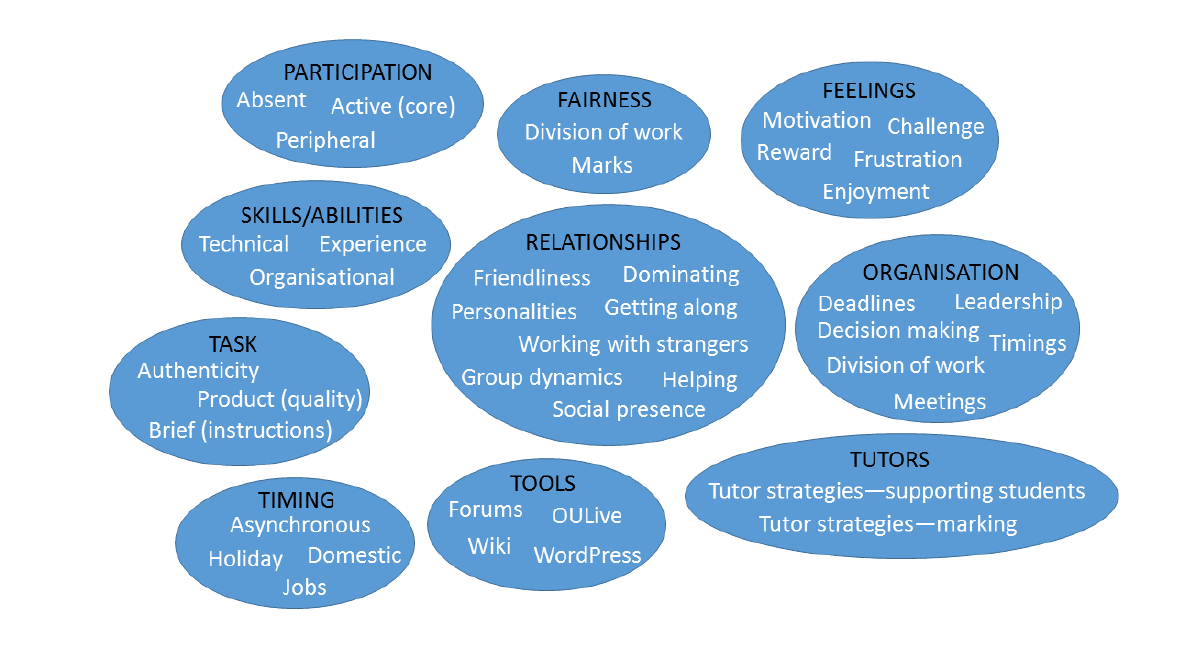
Figure 1 . Codes and subcodes used for student and tutor